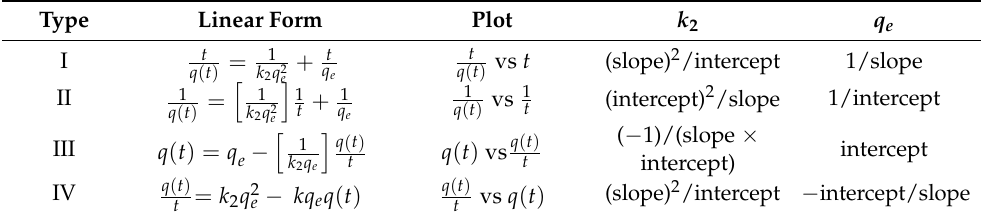
Table 4. Linear forms of PSO model (according to